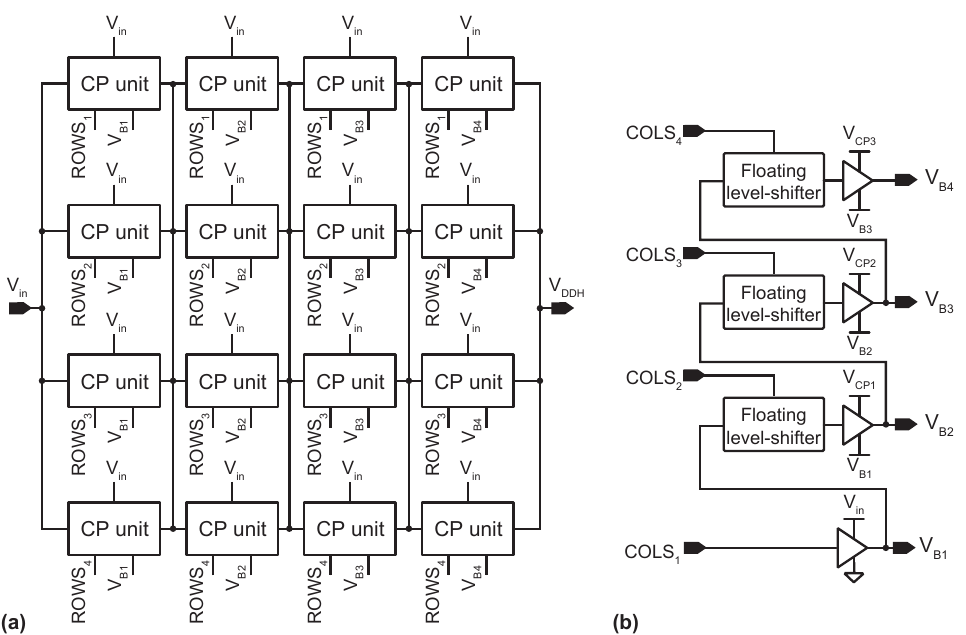
Figure 4. ( a ) Block diagram of the CP array. ( b ) Schematic of the circuit generating the voltage-shifted versions of the column selection signals, COLS i . V CPi corresponds to the output voltage if the i-th column of the CP array.